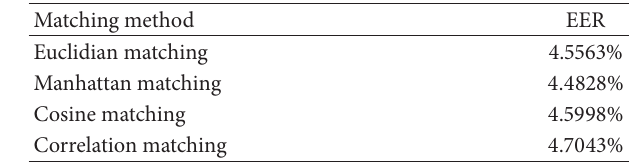
Table 3: Experimental result based WLPP features vector. Table 4: Experimental result LBPV